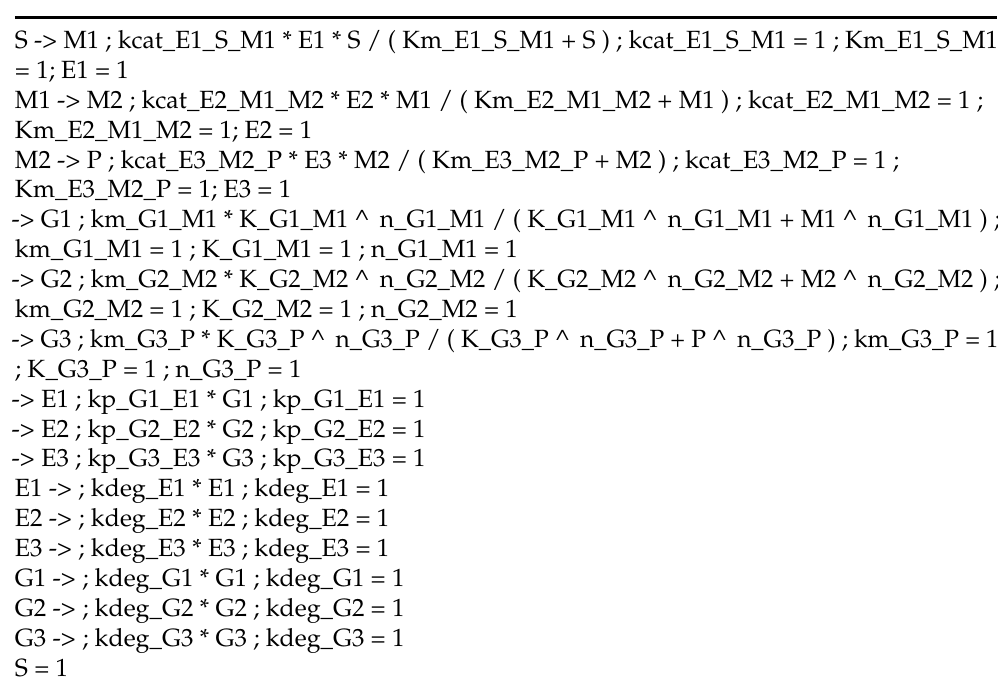
Scheme 3. The three-step model in Antimony language, created by KinModGPT with text-davinci-003 .